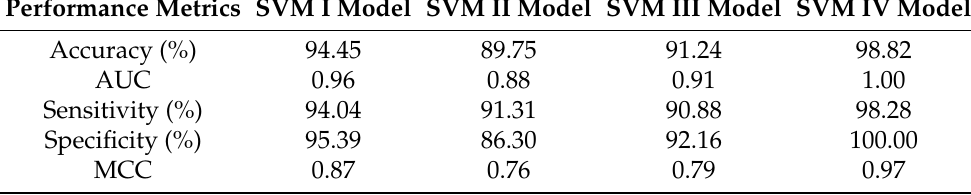
Table 7. Performance analysis of SVM-based decision support